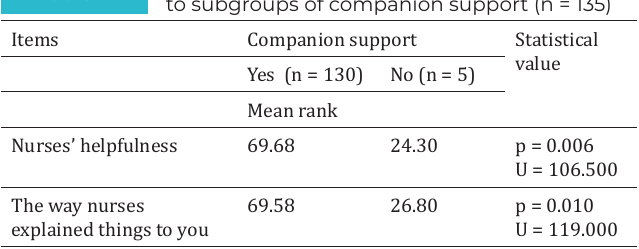
Comparison of patient satisfaction according to subgroups of companion support (n = 135)